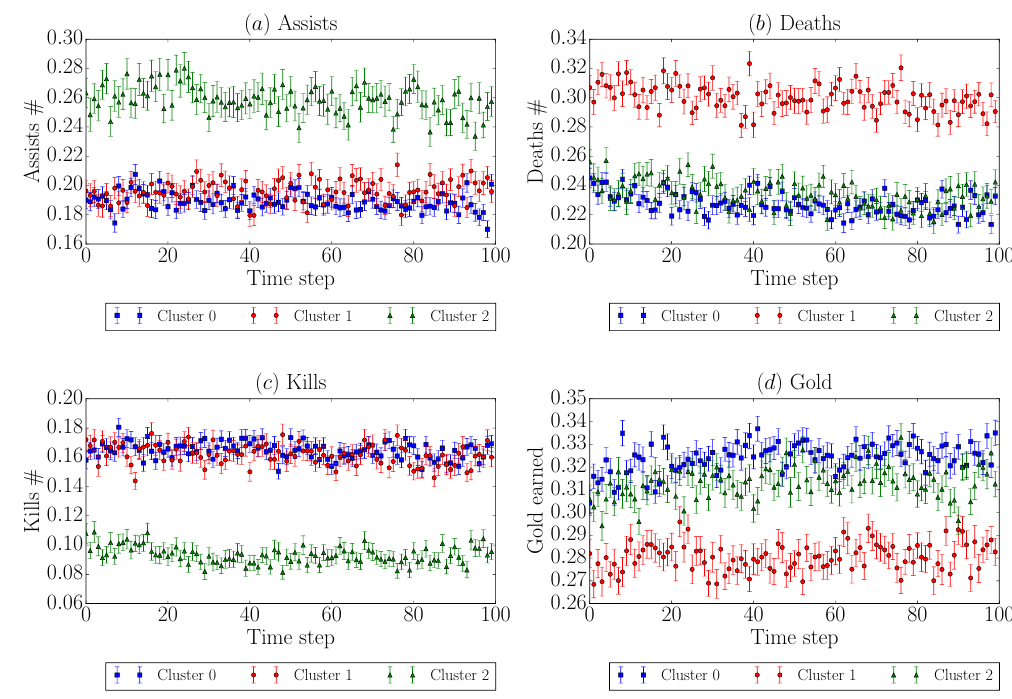
Figure 5. Mean values and related standard errors over time of: ( a ) number of assists; ( b ) number of deaths; ( c ) number of kills; and ( d ) amount of gold earned. We computed the mean and the standard error over the values related to users belonging to the same cluster. Clusters are marked by a unique symbol and color, which is maintained in all the figures, to highlight the different cluster